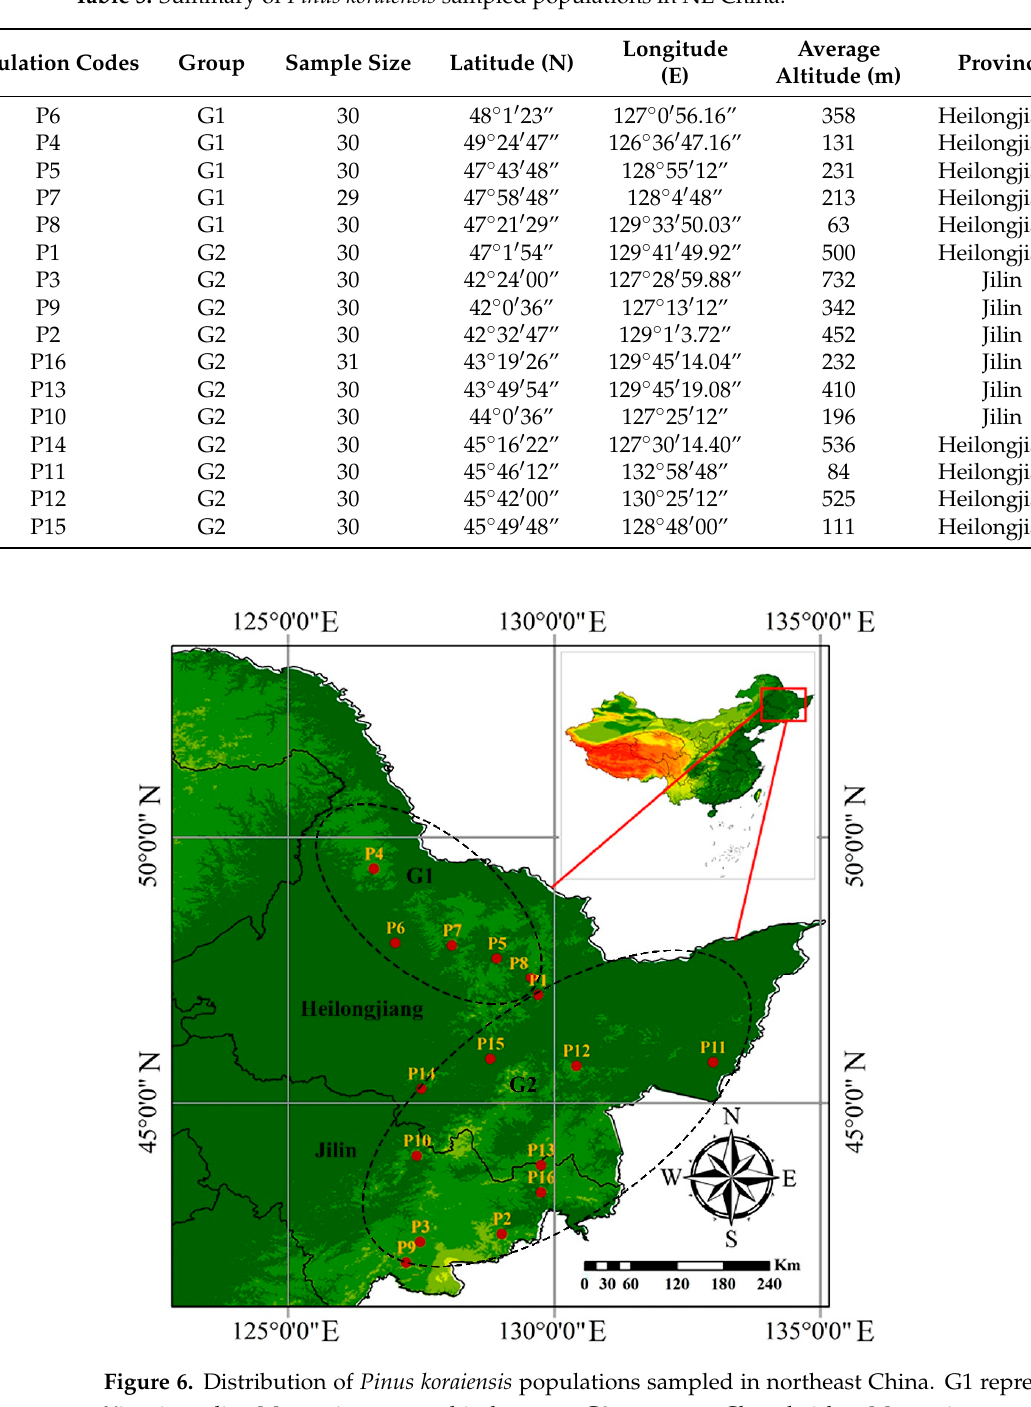
Table 5. Summary of Pinus koraiensis sampled populations in NE China.